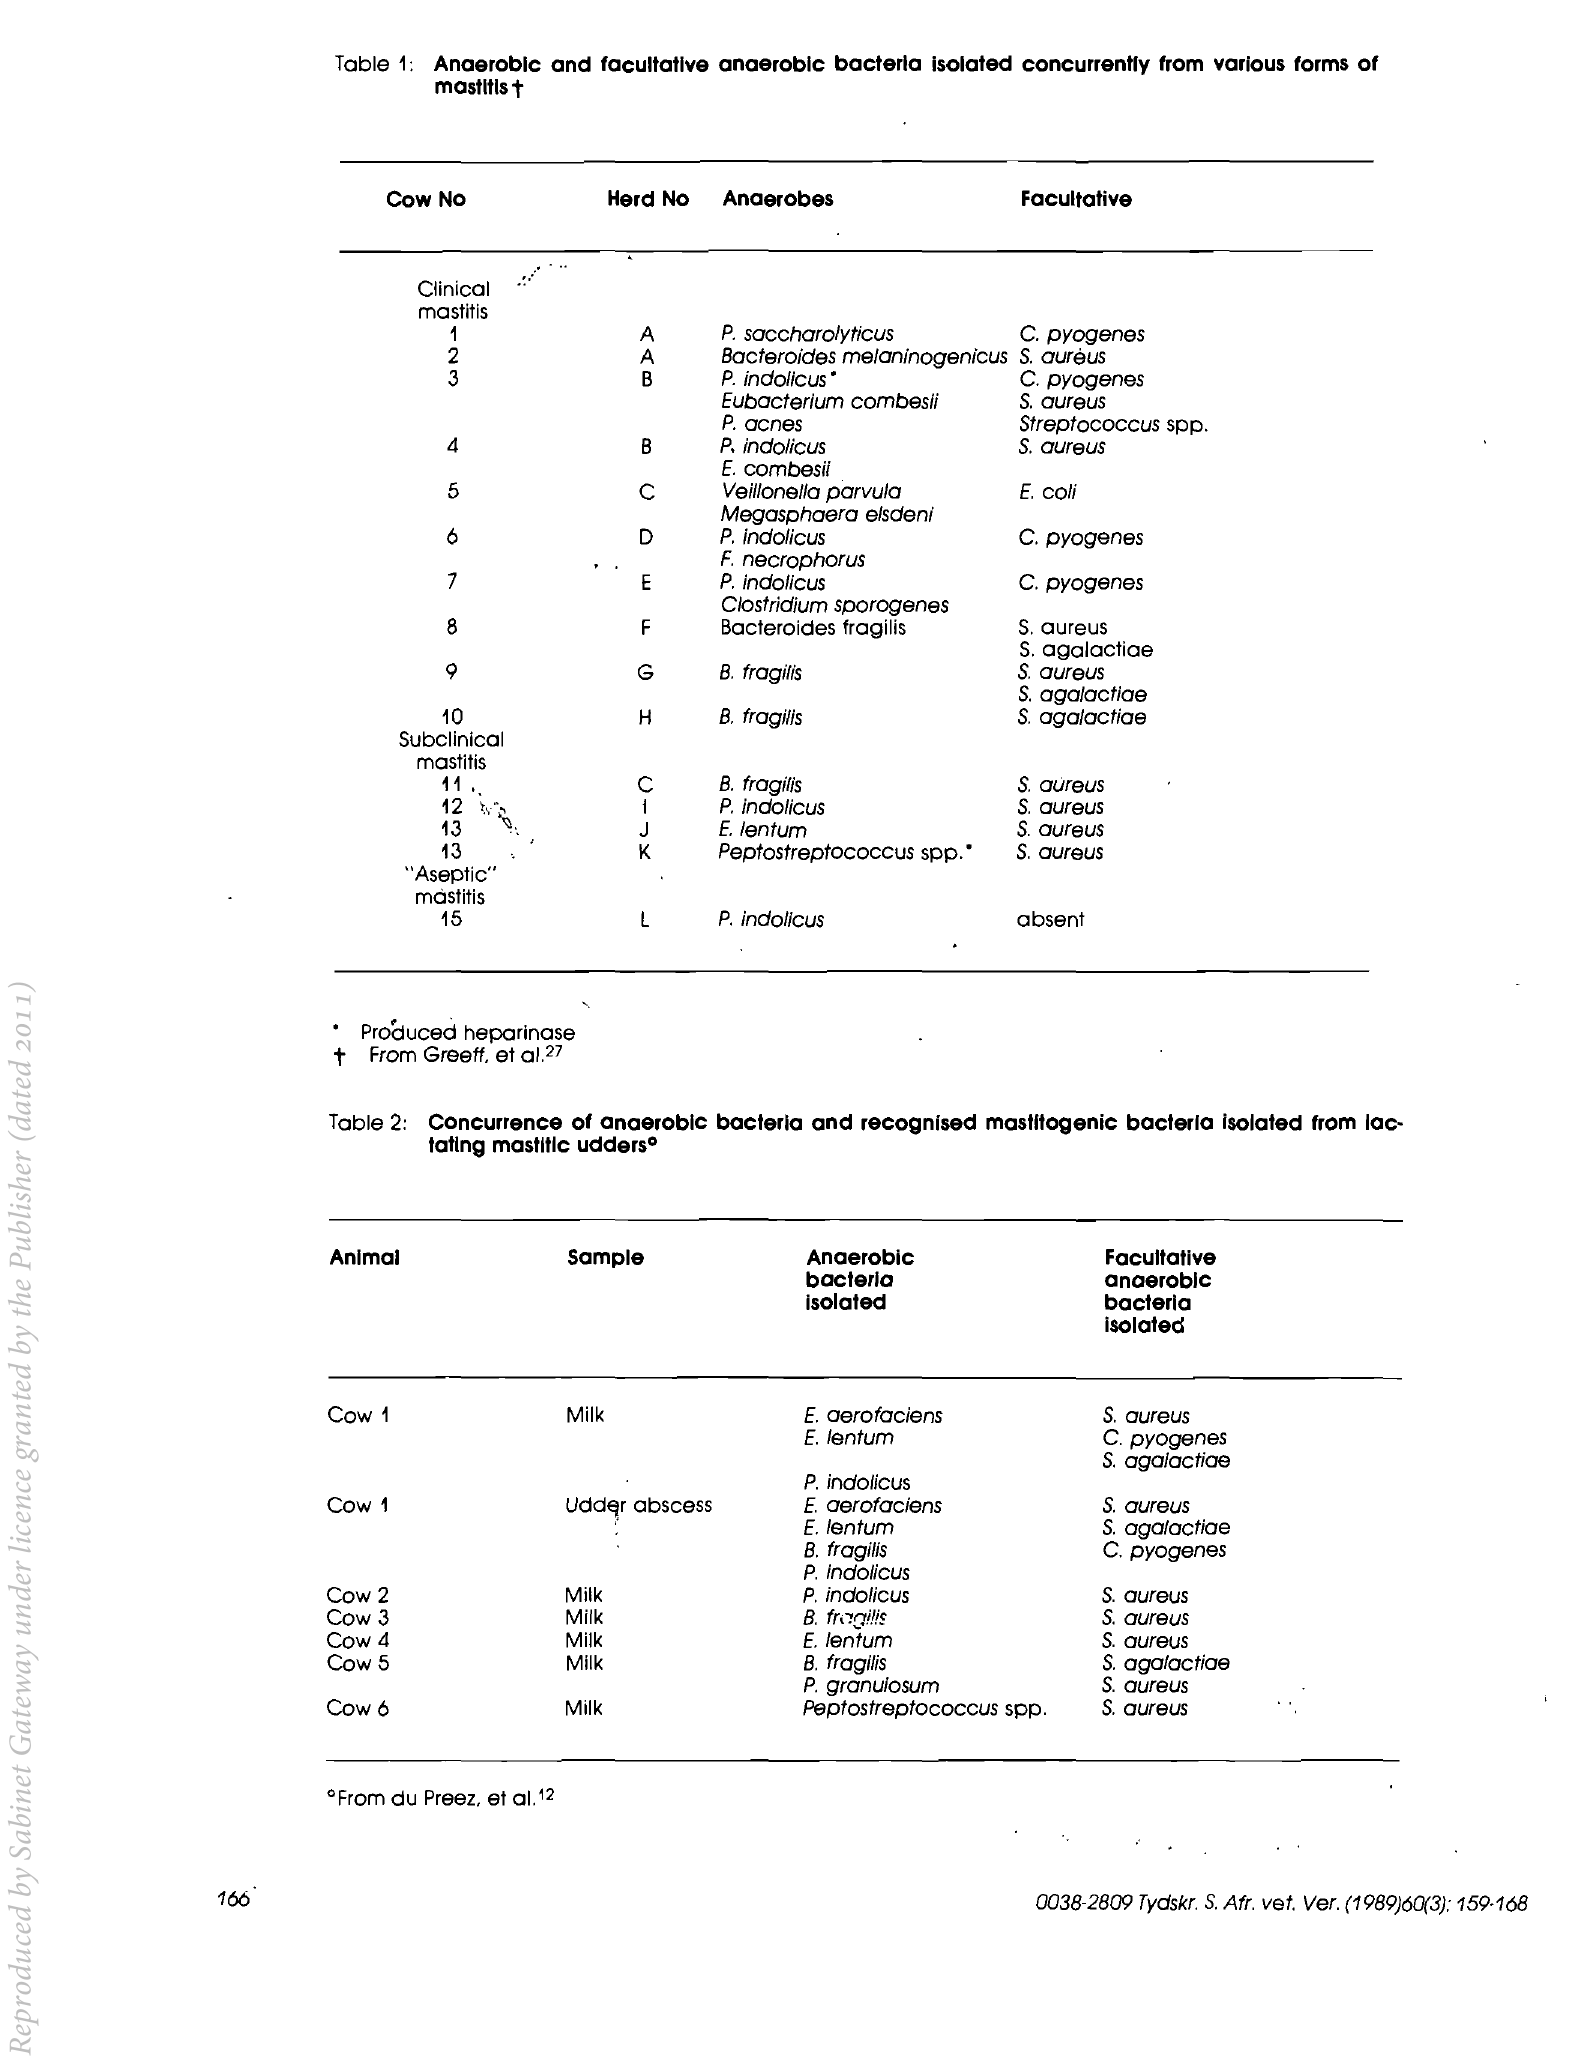
Table 1: Anaerobic and facultative anaerobic bacteria isolated concurrently from various forms of mastltlst